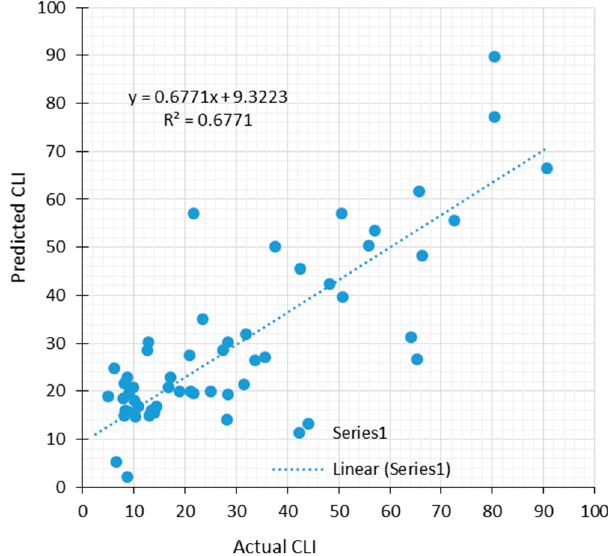
Figure 22. Relations between the actual CLI and estimated CLI by FL model 1 for training.